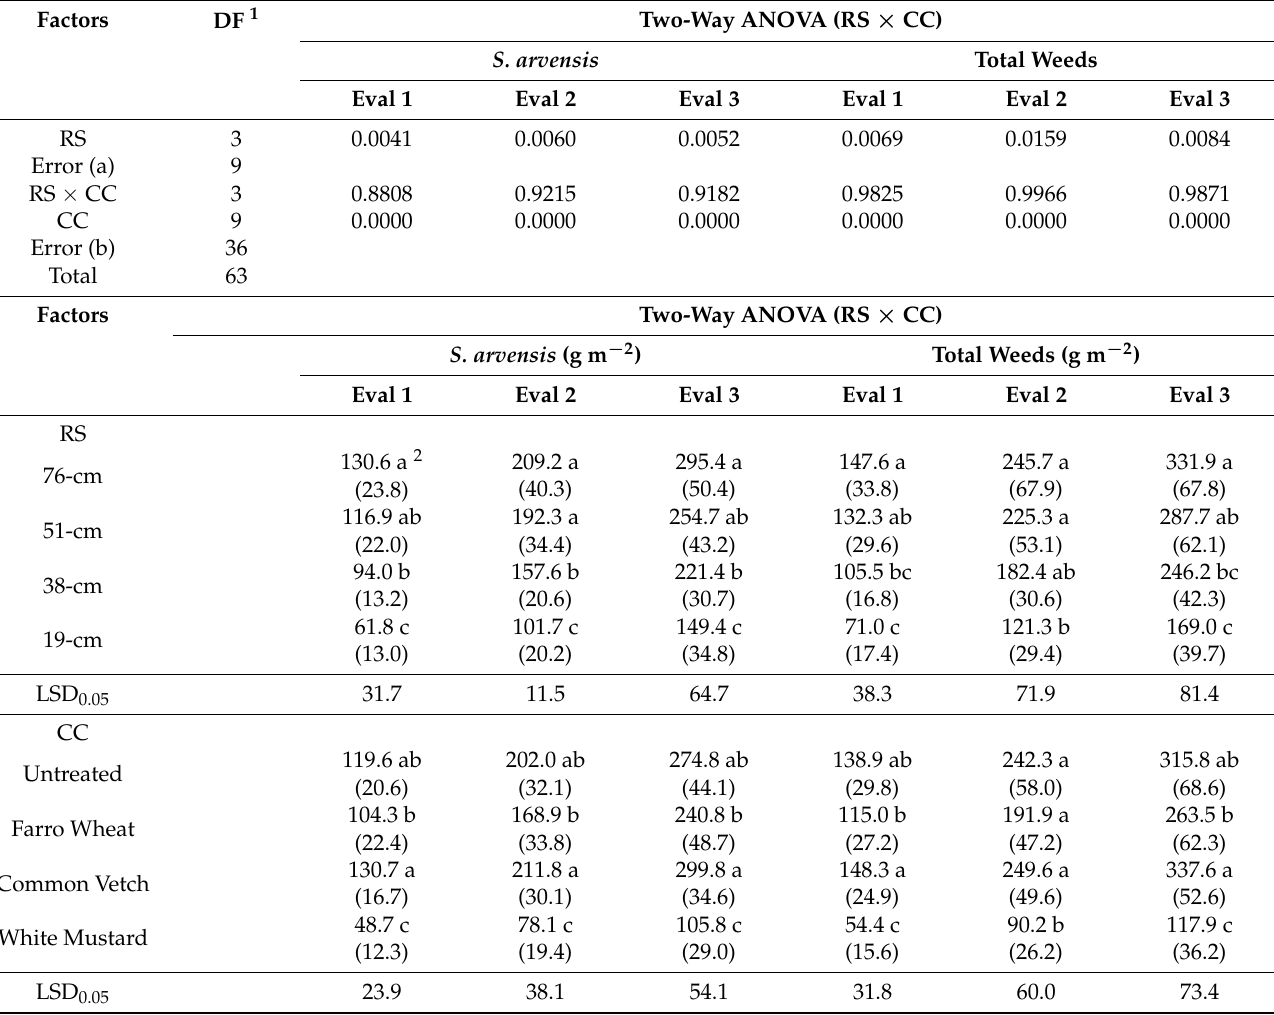
Table 4. The effects of sulla row spacing and cover crops on S. arvensis biomass (g m − 2 ) and total weed biomass (g m − 2 ) in the second year of sulla growth in the 2018–2020 and 2019–2021 growing cycles. Data were pooled across growing